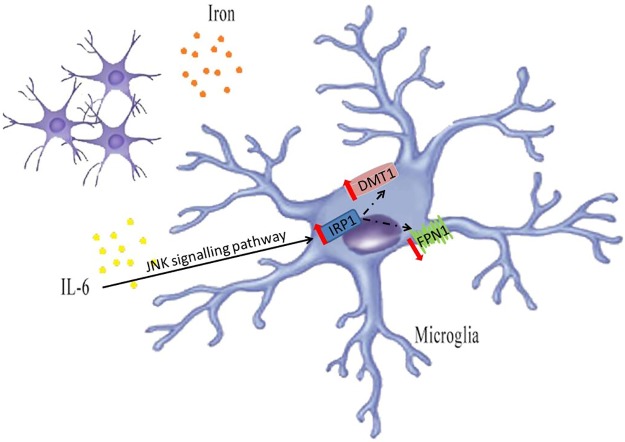
Graphical representation of the mechanism by which iron load can increase IL-6 mRNA expression, and IL-6 can regulate iron related proteins in BV2 cells.Iron load can increase IL-6 mRNA expression in BV2 cells. IL-6 up-regulates DMT1 expression and down-regulates FPN1 expression by IRP1 activation in BV2 microglial cells through JNK signaling pathways.